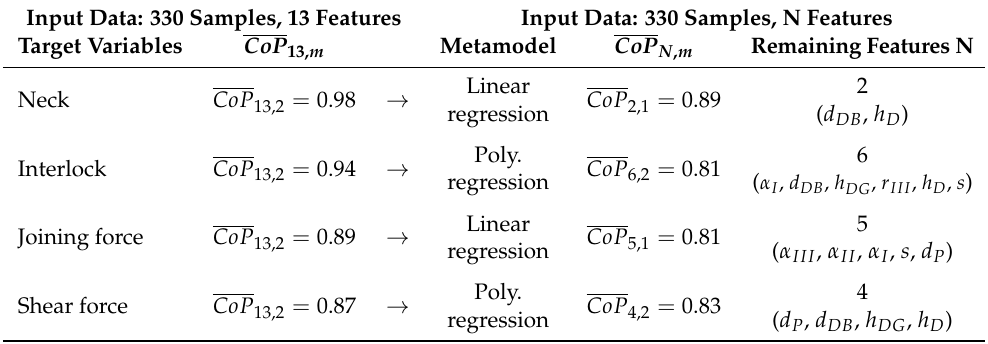
Table 3. Overview of the achieved mean CoP values and the minimum required number of input features for the accurate prediction of individual clinch joint